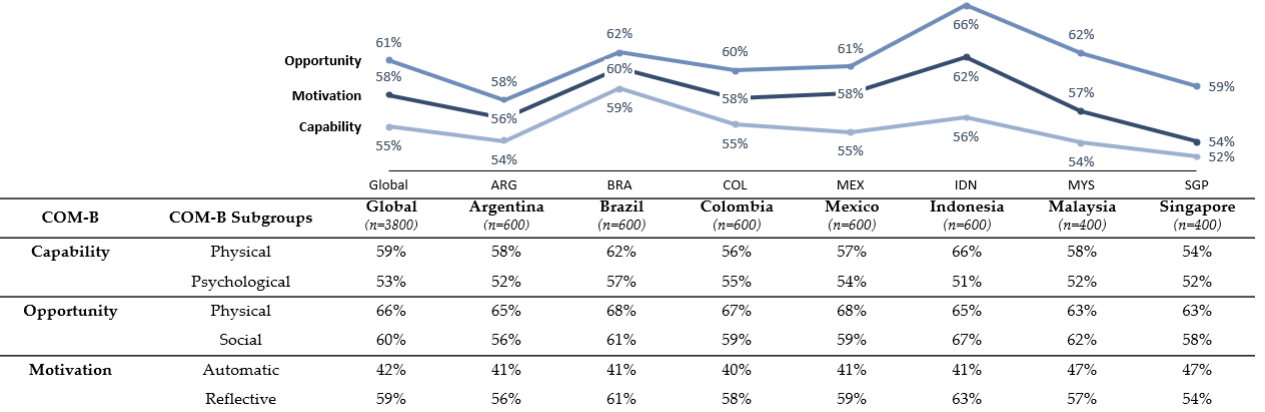
Figure 3. Capability, Opportunity, and Motivation overall composite score and individual factor scores globally and by country.